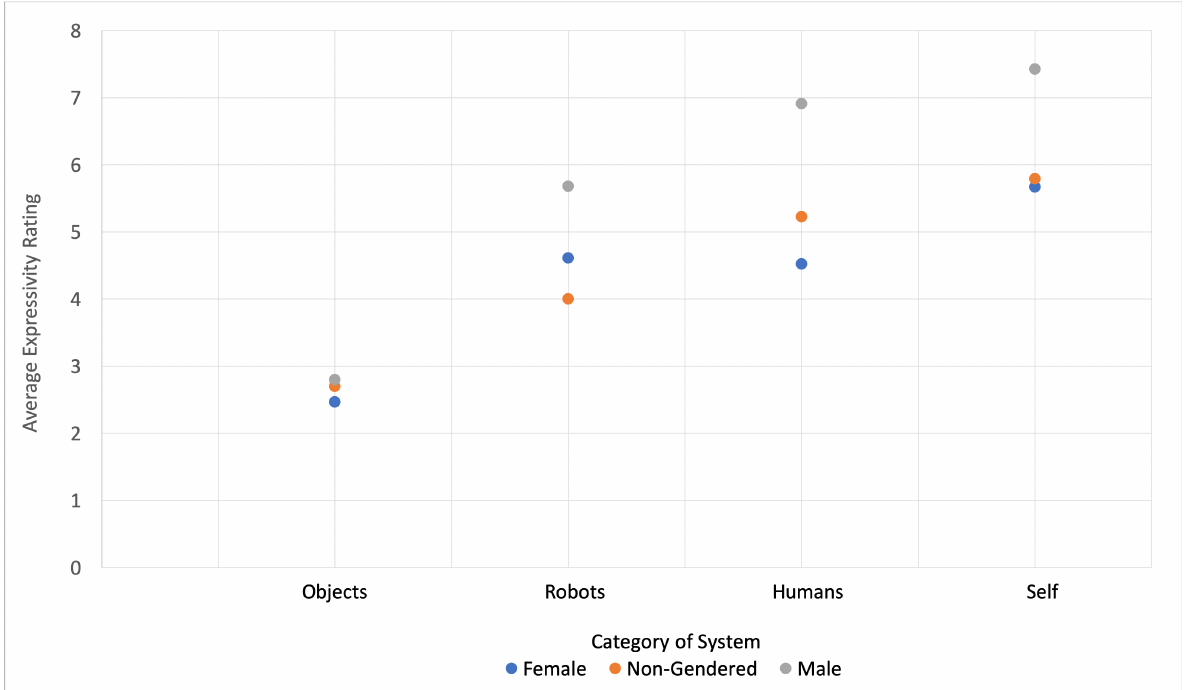
Figure 8: Average Expressivity Rating of 4 main System categories, sorted by a demographic feature, gender. All averages grouped closer together for Objects, while the widest range of average expressivity rating is for the category of Humans. For this participant pool size there was no statistically significant differences according to gender or any other demographic feature; however, this plot illustrates how the ratings for the human and robots were more varied – as is also reflected in the principal component analysis.